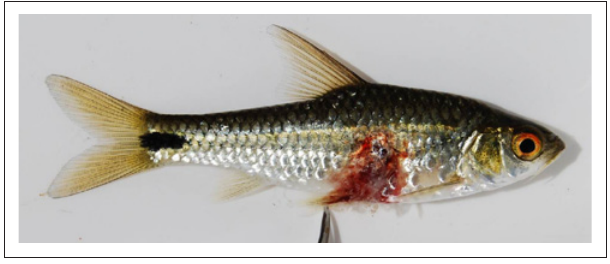
FIGURE 3: Tissue necrosis associated with an intense inflammatory reaction in an early lesion in a dashtail barb ( Barbus poechii ) from the Kabompo River, upper TABLE 2: Prevalence of fish with presumptive epizootic ulcerative syndrome lesions from the 2008 Zambezi Classic Angling Competition held at Kalimbeza, from 22 to 25 August 2008. Fish species Number weighed in and inspected Number with ulcers Percentage infected Threespot tilapia ( Oreochromis andersonii ) 32